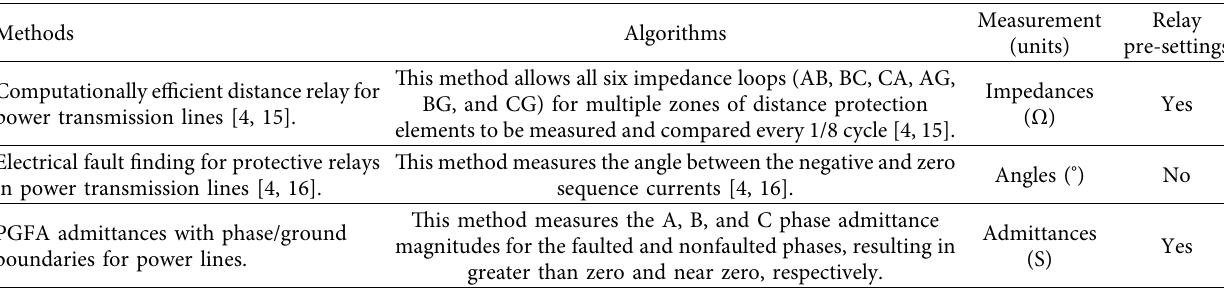
Measurement Relay (units) pre-settings